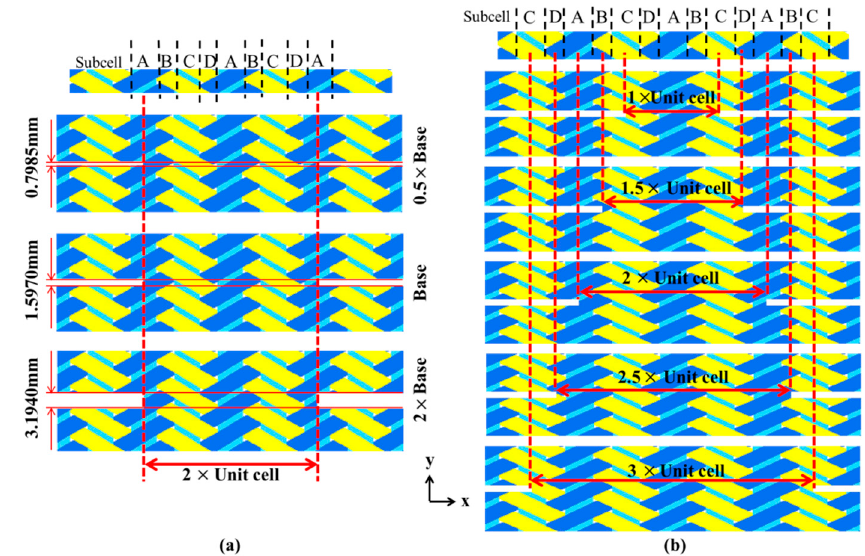
Figure 10. Mesoscale models of notched specimens with different geometrical characteristics. ( a ) Different notch sizes. ( b ) Different widths of the gauge section (with complete axial tows between notches).